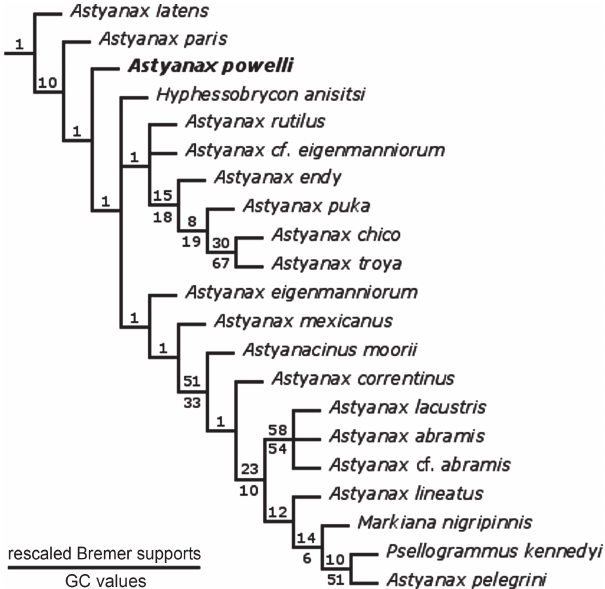
Fig. 5. Detail of the Astyanax clade in the most parsimonious tree obtained from values of K between 5.26 and